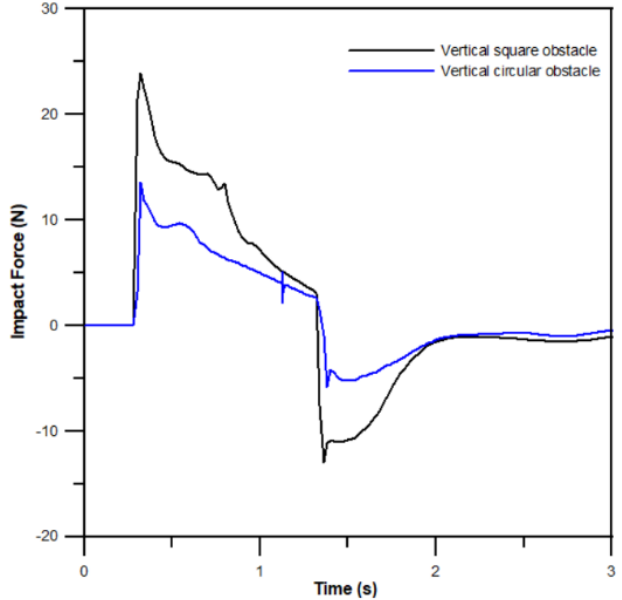
Figure 9. Time variation of the impact force on the vertical square and circular obstacle.